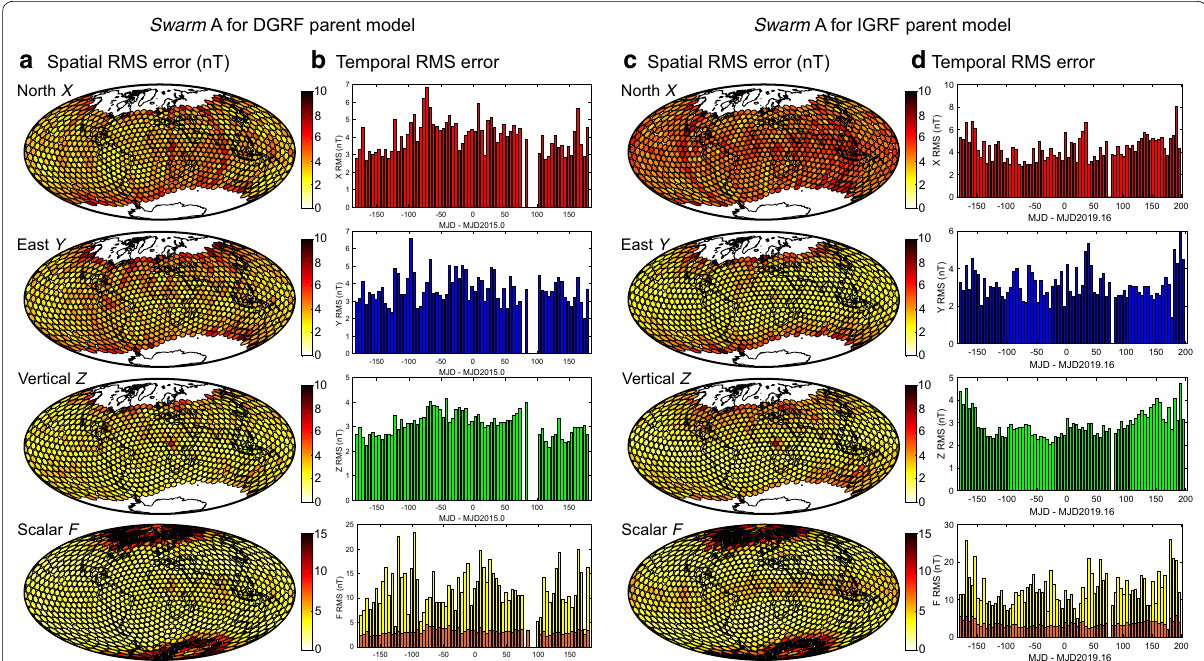
Fig. 6 RMS errors for each vector and scalar elements for the Swarm A data. Columns (a) and (c) represent the maps of the RMS errors for the DGRF and IGRF parent models, respectively. Columns b) and d) provide the RMS errors as a function of the modified Julian days relative to 2015.0 and 2019.16 for DGRF and IGRF,